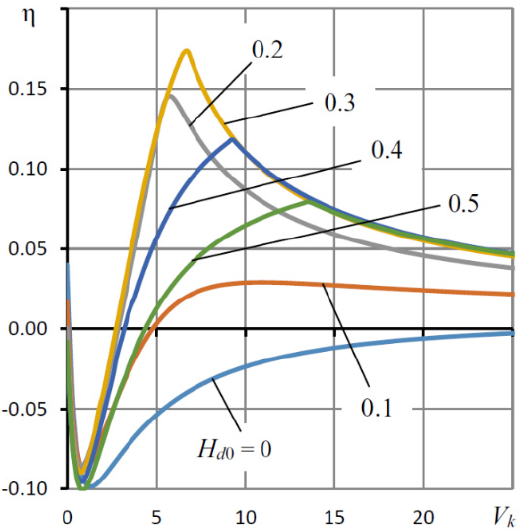
Figure 5. Graph of the dependence of the stability degree η on the volume V k for different values of the parameter H d 0 at σ = 25.